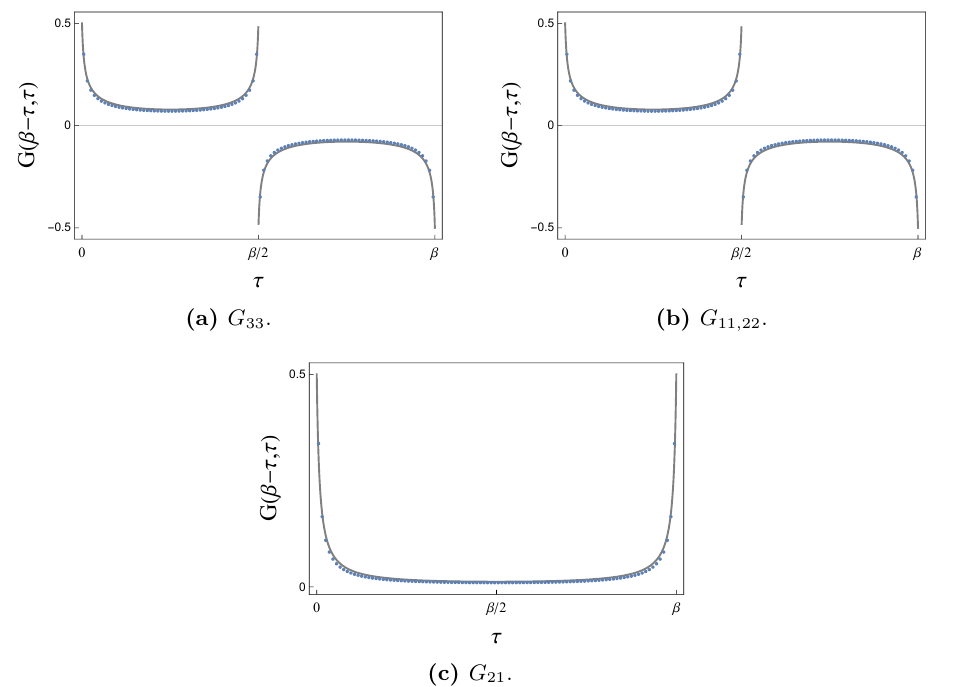
Figure 4. A comparison between numerical (represented by blue dots) and large- q analytical (represented by gray curves) solutions for the diagonal components of the Green’s function. The parameters are β J = 20 , q = 4 . The imaginary time contour with length β is discretized into 100 intervals. (a) The unmeasured Majorana fermions’ Green’s function G 33 ( τ 1 , τ 2 ) . (b) The measured Majorana fermions’ Green’s functions G 11 ( τ 1 , τ 2 ) , G 22 ( τ 1 , τ 2 ) . Note that G 11 ( τ 1 , τ 2 ) = G 22 ( τ 1 , τ 2 ) = G 33 ( τ 1 , τ 2 ) as expected by the flip symmetry argument in equation (2.24). (c) The measured Majorana fermions’ Green’s function G 21 ( τ 1 , τ 2 )